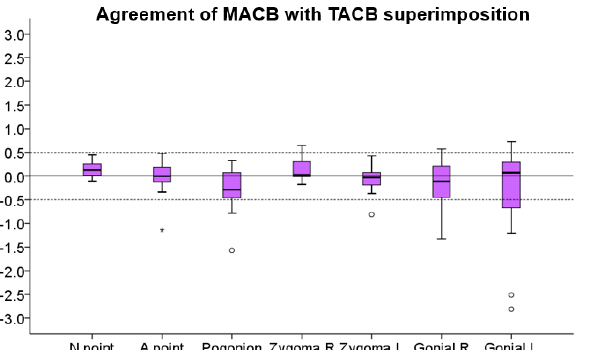
Figure 4. Box plots showing the agreement of the MACB (Middle Anterior Cranial Base) with the TACB (Total Anterior Cranial Base) superimposition for the detected T0–T1 changes in mm, for all measurement areas. The zero value, depicted by the continuous horizontal line, indicates perfect agreement, whereas any deviation from zero is considered a disagreement. The dashed lines indicate 0.5 mm and −0.5 mm. In the boxes, the upper limit of the black line represents the maximum value, the lower limit the minimum value, the box the interquartile range, and the horizontal black line the median value. Outliers are shown as black dots or stars in more extreme cases.